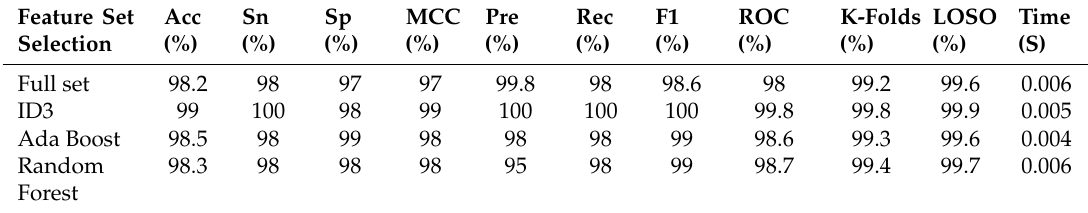
Figure 6. Accuracy on selected features set by DT-ID3 with different validation methods. Table 6. Classification Performance with and without selected feature set by Filter FS algorithms.